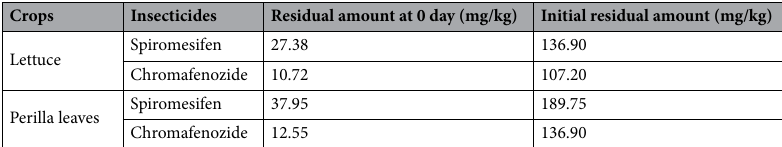
Table 2. Initial residues of spiromesifen a and chromafenozide in lettuce and perilla leaves. a Total residues of spiromesifen (mg/kg) = spiromesifen + (BSN2060 residue × 1.36).